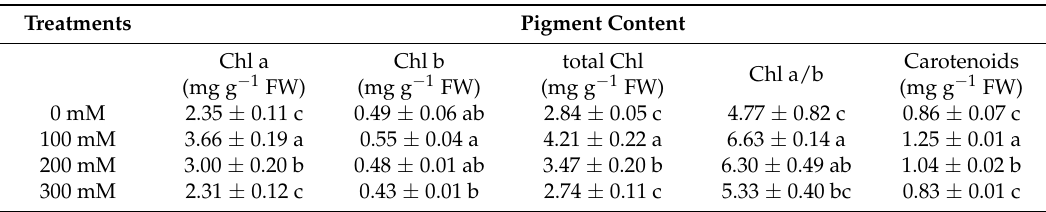
Table 1. Effects of different NaCl concentrations on the chlorophyll (Chl) and carotenoids contents of AVF.